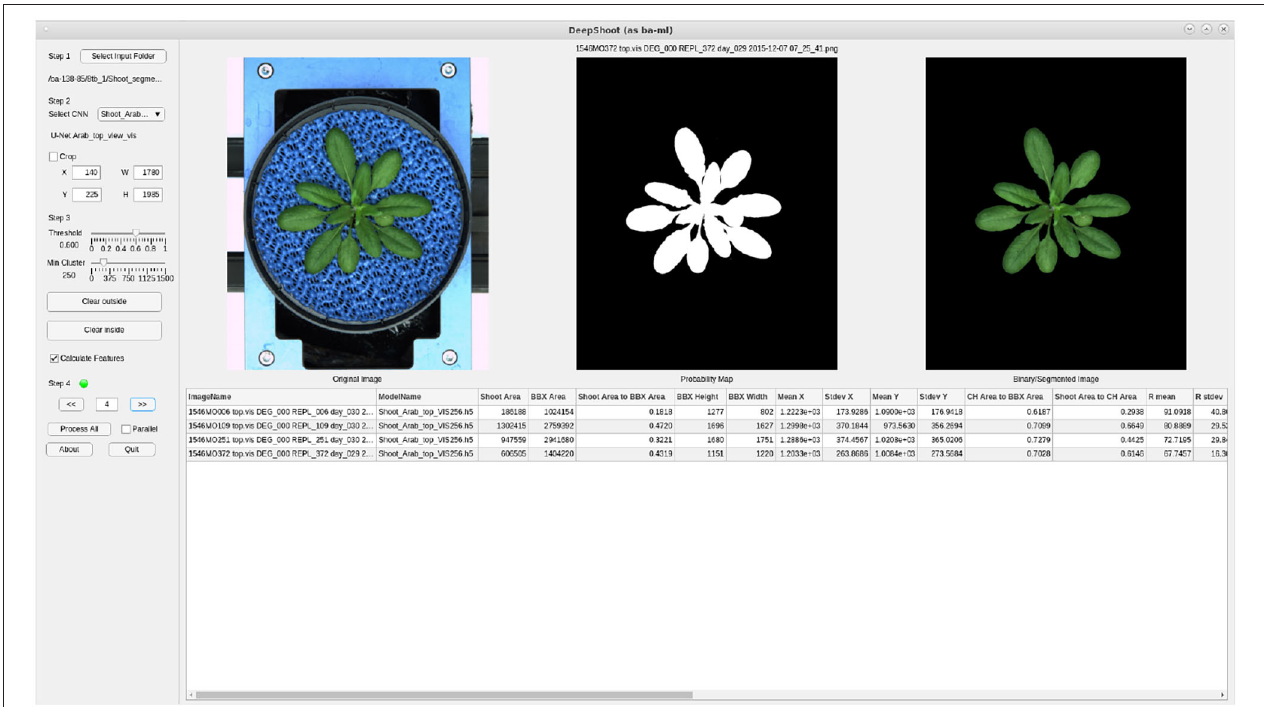
FIGURE 12 | Graphical User Interface of the DeepShoot tool: left, middle, and right images represent the original image, predicted probability map, and predicted color image, respectively.